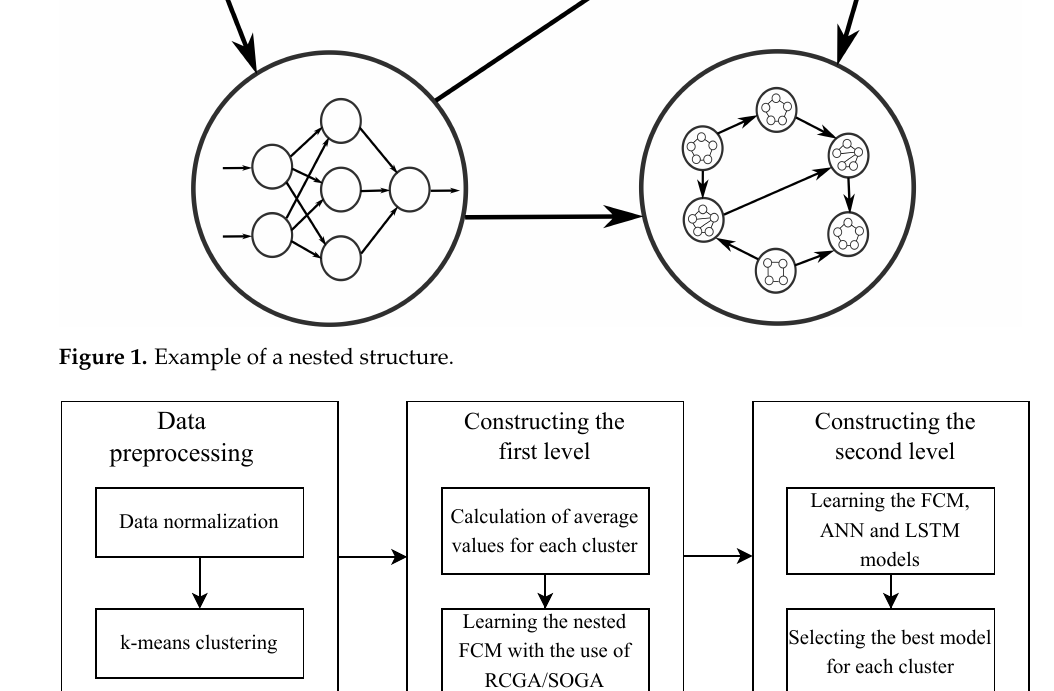
Figure 2. Architecture of the proposed